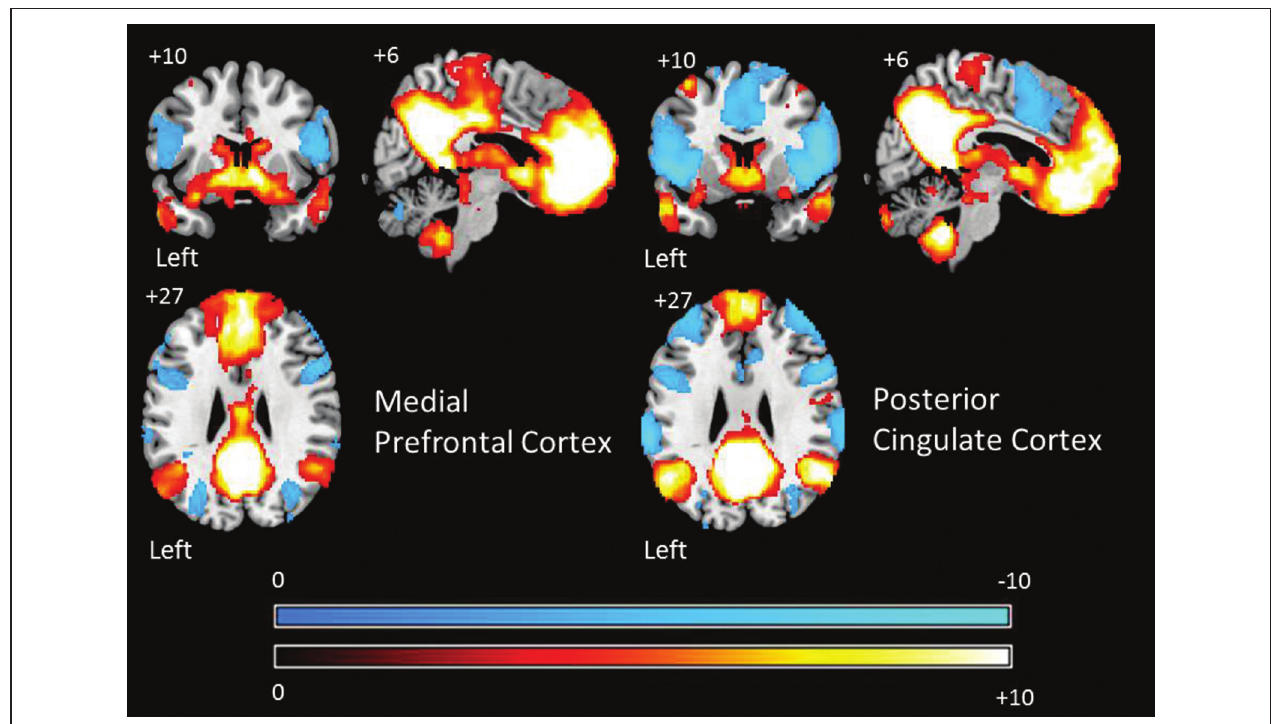
regions exhibiting positive correlations and cold colors indicate regions exhibiting negative correlations. For the purpose of display these maps are thresholded at a T -value of +/ − 3. All results are overlaid on a standard MNI template.